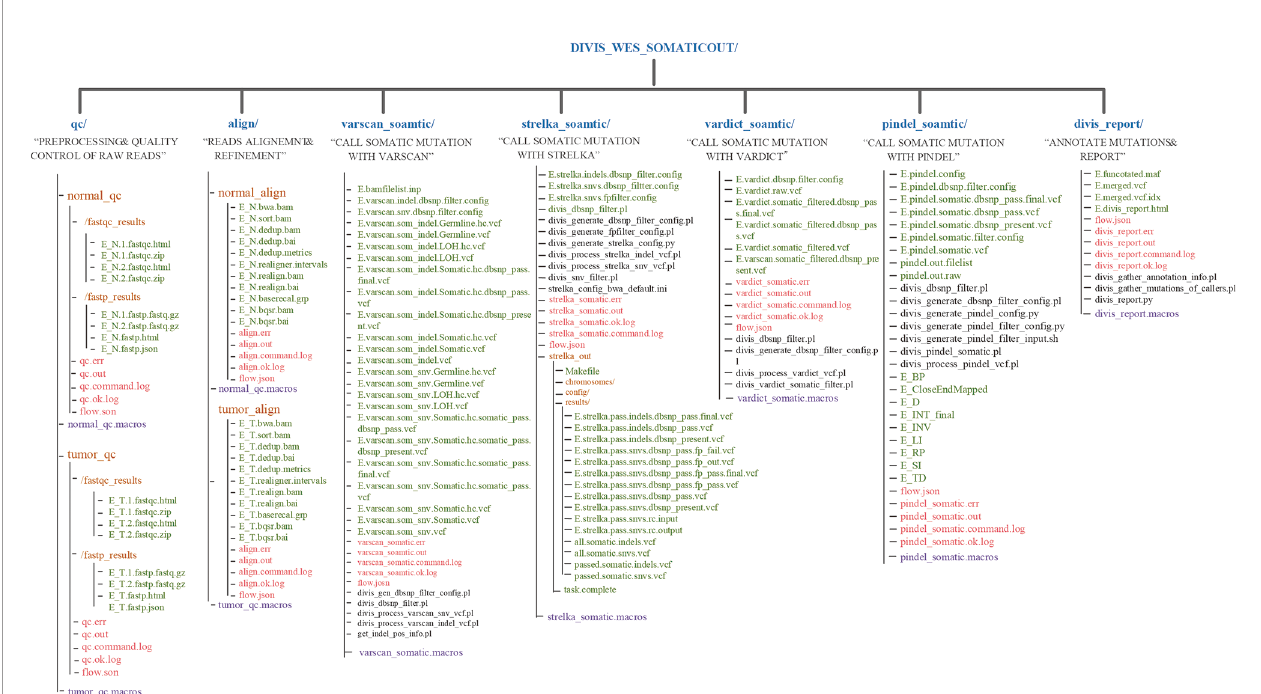
FIGURE 5 | The output directory of DIVIS command “ wes_somatic. ” In the user speci fi ed output directory, “ DIVIS_WES_SOMATICOUT, ” DIVIS creates independent directories for each “ substep, ” such as qc/, align/, varscan_ somatic/, etc. The output fi les related to data analysis are marked in green font. Most of the output fi les of DIVIS are named incrementally, which makes the fi le name self-evident. Therefore, users can intuitively judge the speci fi c logical relationship of output fi les. The purple font marks the macro information of the DIVIS command and the red font marks the auxiliary information of GPyFlow_CLI, including “ *.command.log, ” “ *. ok.log, ” “ *.out, ” and “ *. err.